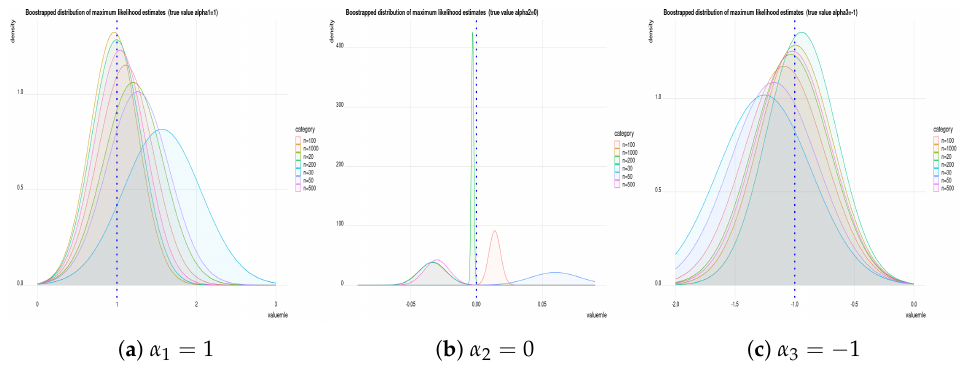
Figure 1. Boostrapped distribution of α = ( α 1 , α 2 , α 3 ) (cid:62)